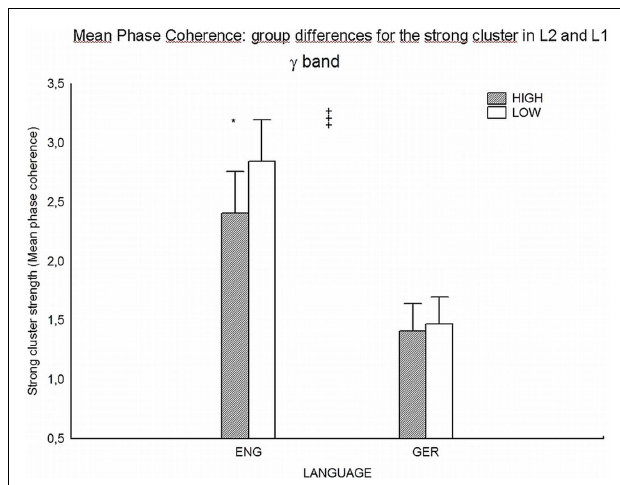
FIGURE 8 | Mean Phase Coherence: differences between the groups during L2 (“ENG,” left double bar) and L1 (“GER,” right double bar) processing. Dark bars indicate the high proficiency group and white bars the low proficiency group. Difference in mean phase coherence is significant ( p = 0.42) between the groups during processing L2 English (increased synchronization strength for LP group), but not during processing L1